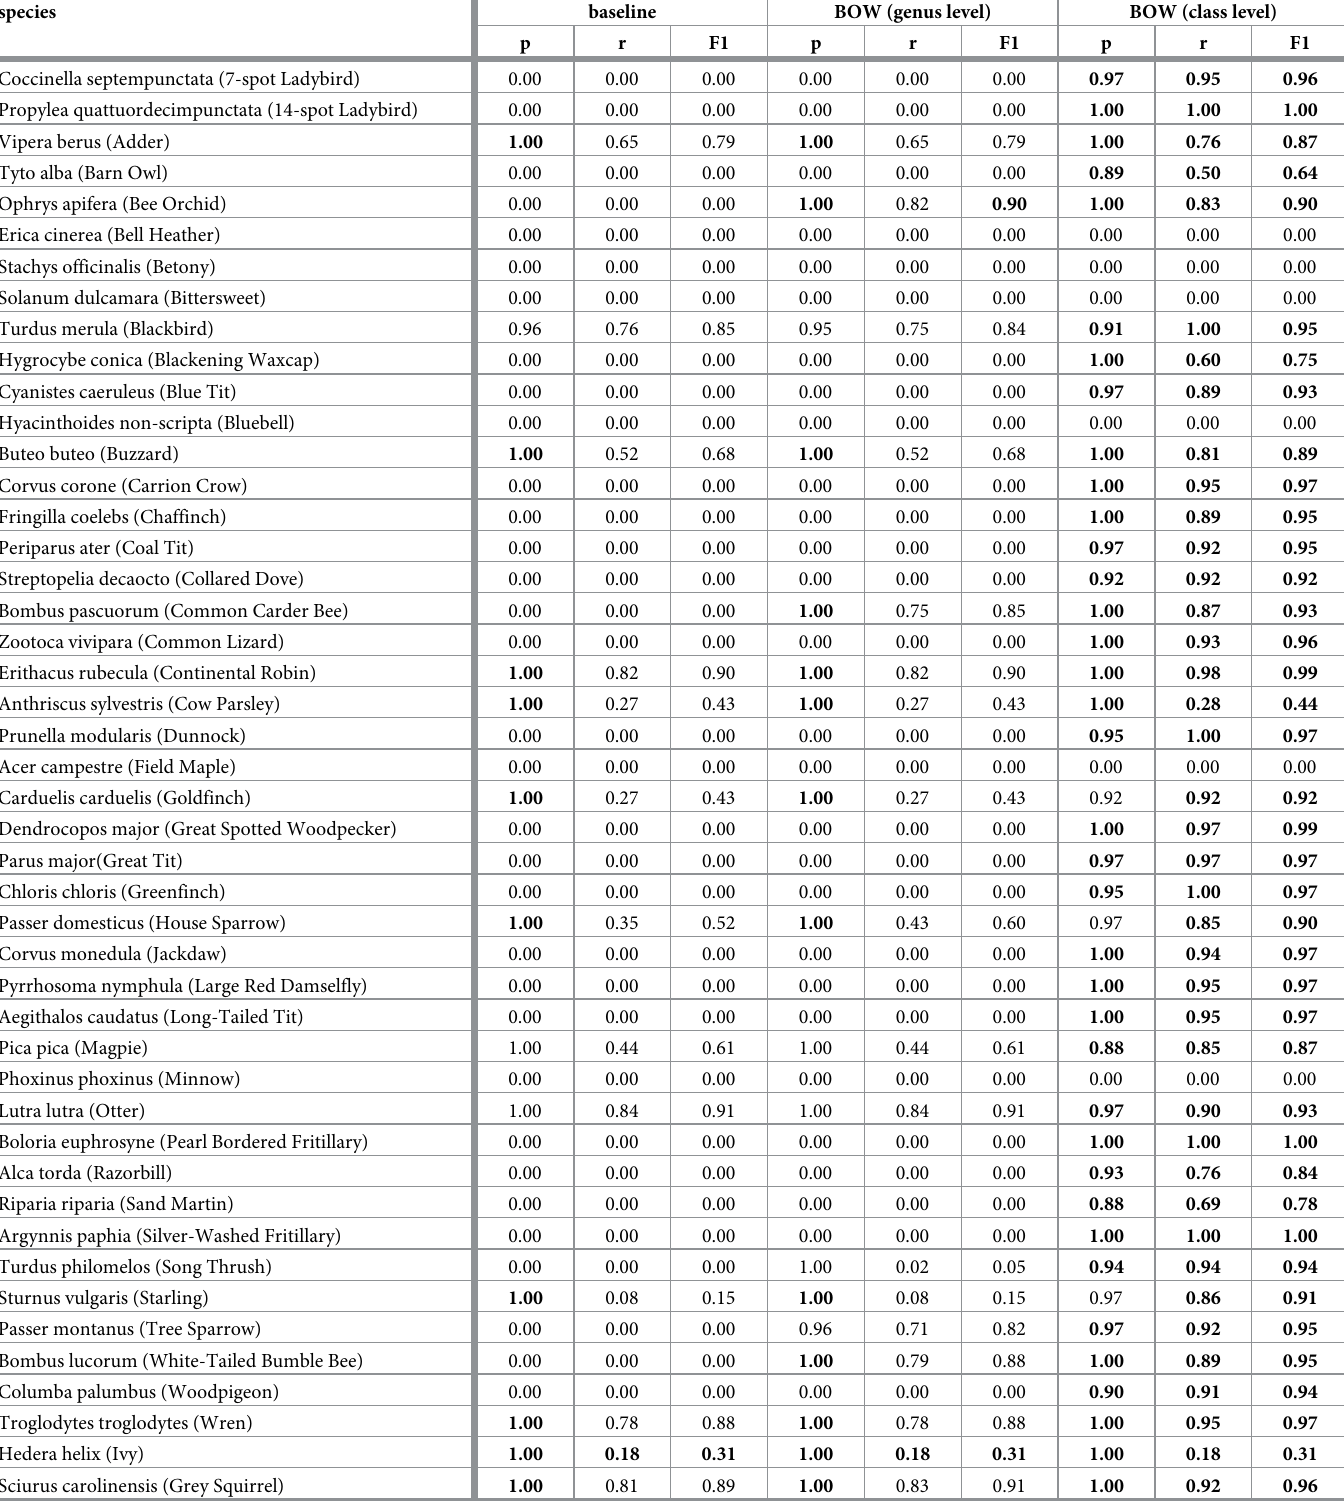
Table 5. Comparison between class-level and genus-level BOW image verification approaches and the baseline approach, based on exact-match approach.